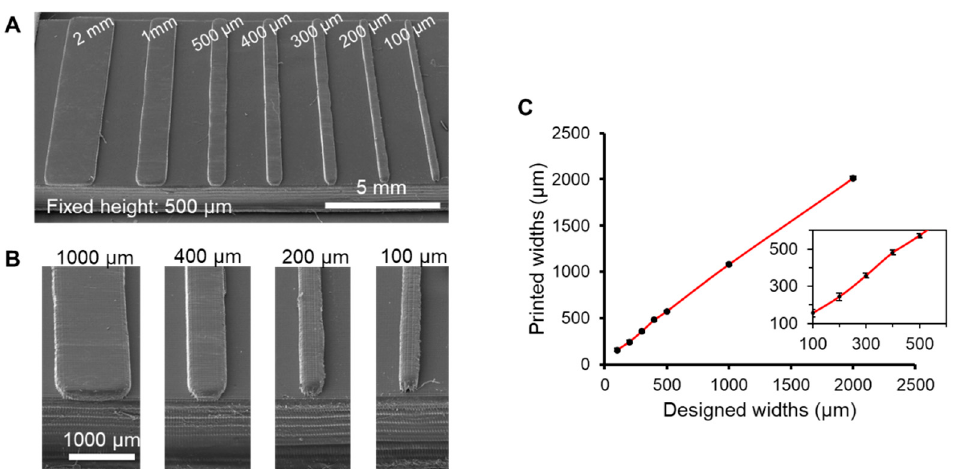
Figure 2. Characterization of the feature resolution in the horizontal direction. ( A ) SEM images of the line patterns printed for characterization. The heights of the patterns were fixed at 500 µm. The value above each line indicates the designed widths of the specific line. ( B ) Zoom-in images of the line patterns with the designed widths of 1000, 400, 200, and 100 µm. ( C ) Relationship between designed widths and printed widths. The printed width is slightly greater than the designed one due to the overcuring.